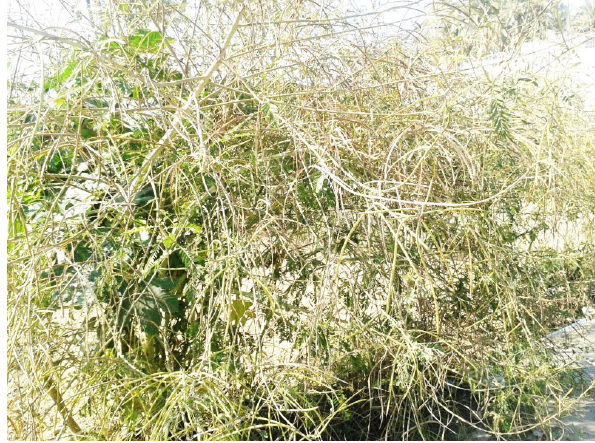
Figure 1: Sesbania sesban